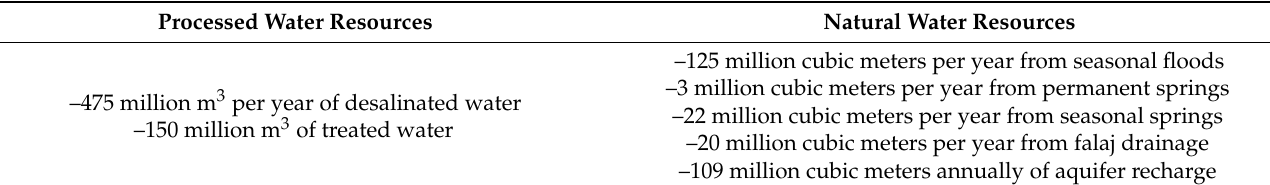
Figure 8. Total water accumulation in dams [72]. Table 11. UAE Non-Conventional and Conventional Water Resources.